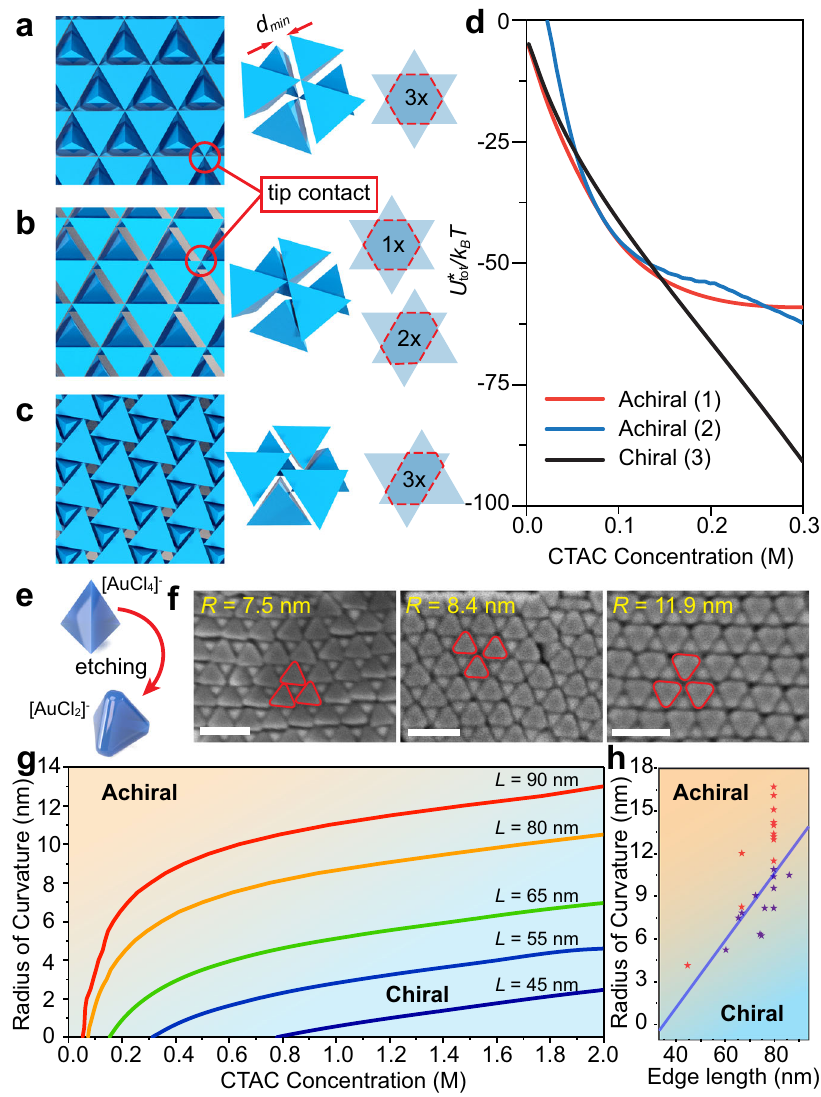
Fig. 3 Understanding the stability of different 2D tetrahedra lattices. Schematic illustration of the lattice, hexagonal repeat unit, and particle-particle overlap area for: a achiral (1), b achiral (2), and c chiral (3) structures described in the text. The closest distance two particles can approach ( d min ) is set by the speci fi c packing geometry. d Comparison of different superlattice energies as a function of hexadecyltrimethylammonium chloride (CTAC) concentration showing the ultimate stability of the chiral hexagonal (3) phase. e Illustration of the rounding of tips and edges as a result of selective oxidation of gold tetrahedra (Td) particles. f SEM images of the solvent evaporation-based assembly of Td particles with different tip radii (R), indicated in yellow. g Calculated concentration-dependent phase stability of achiral (1) and chiral (3) structures as a function of Td tip radius; separate lines are for Td with differing edge lengths. h Phase diagram predicting the stability of achiral (1) or chiral (3) structures at the endpoint of the assembly process based on particle size and tip radius; blue line is calculated phase boundary while red and purple dots indicate experimental observation of the achiral or chiral structures, respectively. All scale bars are 100